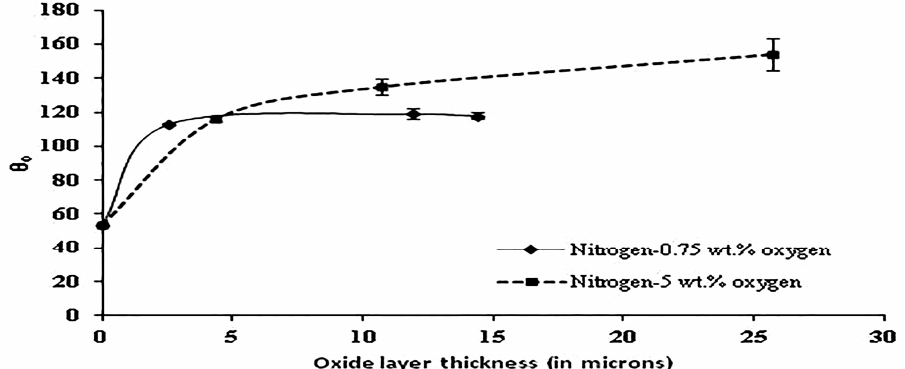
Figure 7. Plot of the underwater oil contact angle as a function of the oxide layer thickness.